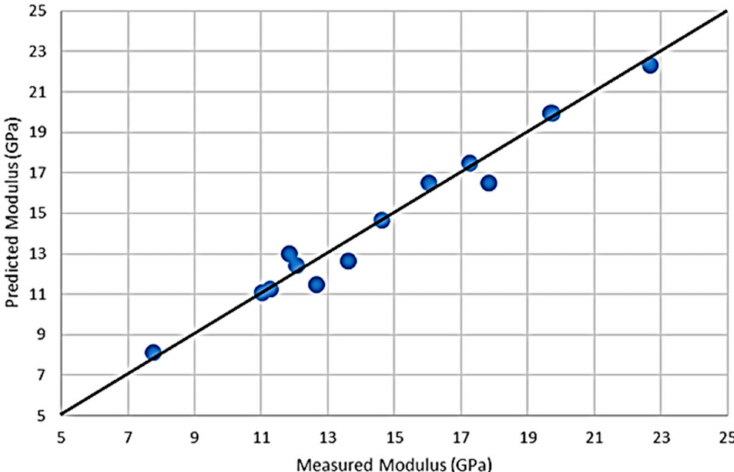
Figure 7. Measured versus predicted average formation dynamic bulk and shear moduli using Equations (9) and (10) and the data from Table 1. These equations indicate that average moduli are primarily dependent on volume fractions of clay and TOC. Despite ignoring other variables, they still match the observed average moduli with high correlation and a standard error within 1 GPa. All other variables surprisingly do not improve the fit or significance of the regressions. We suspect that geological correlations reduce the additional prediction error reduction that can be achieved by including factors such as porosity, fluid content, or e ff ective pressure.